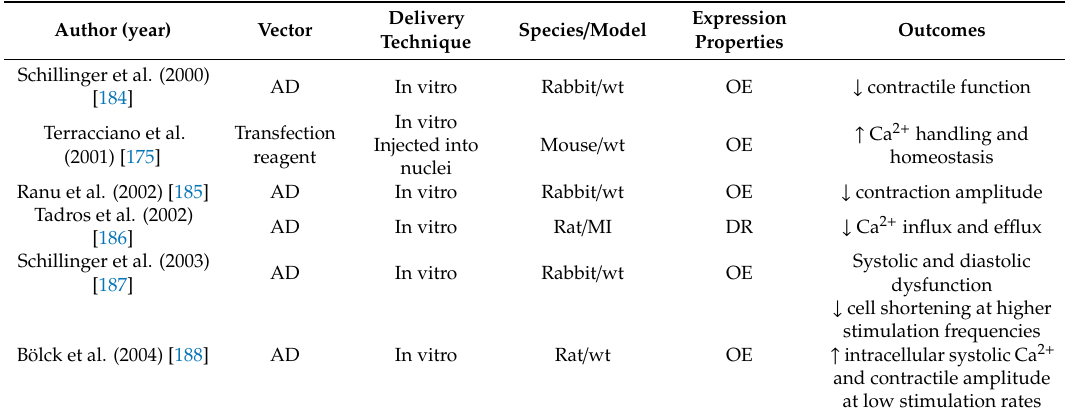
Table 5. Downregulation or overexpression of cardiac Na + / Ca 2 + exchanger